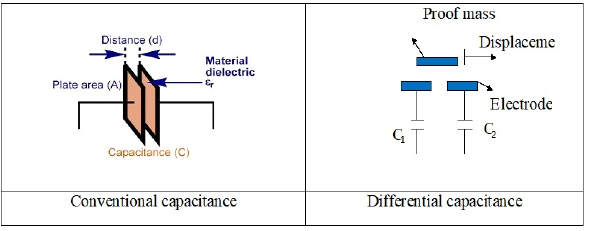
Figure 7: Differences between ordinary capacitance and differential